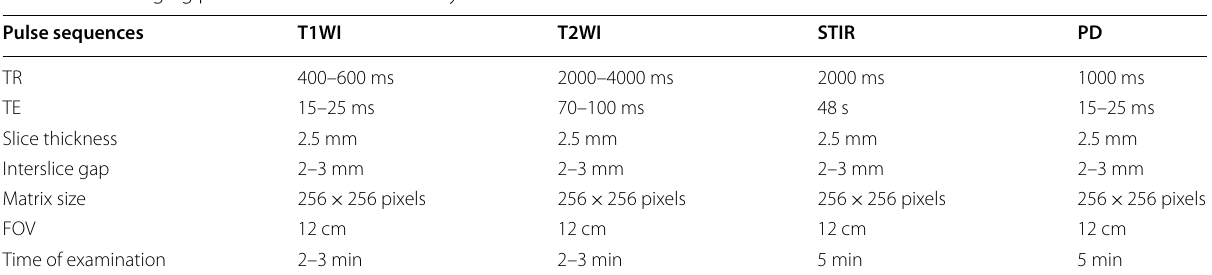
Table 1 MR imaging parameters used in the study Pulse